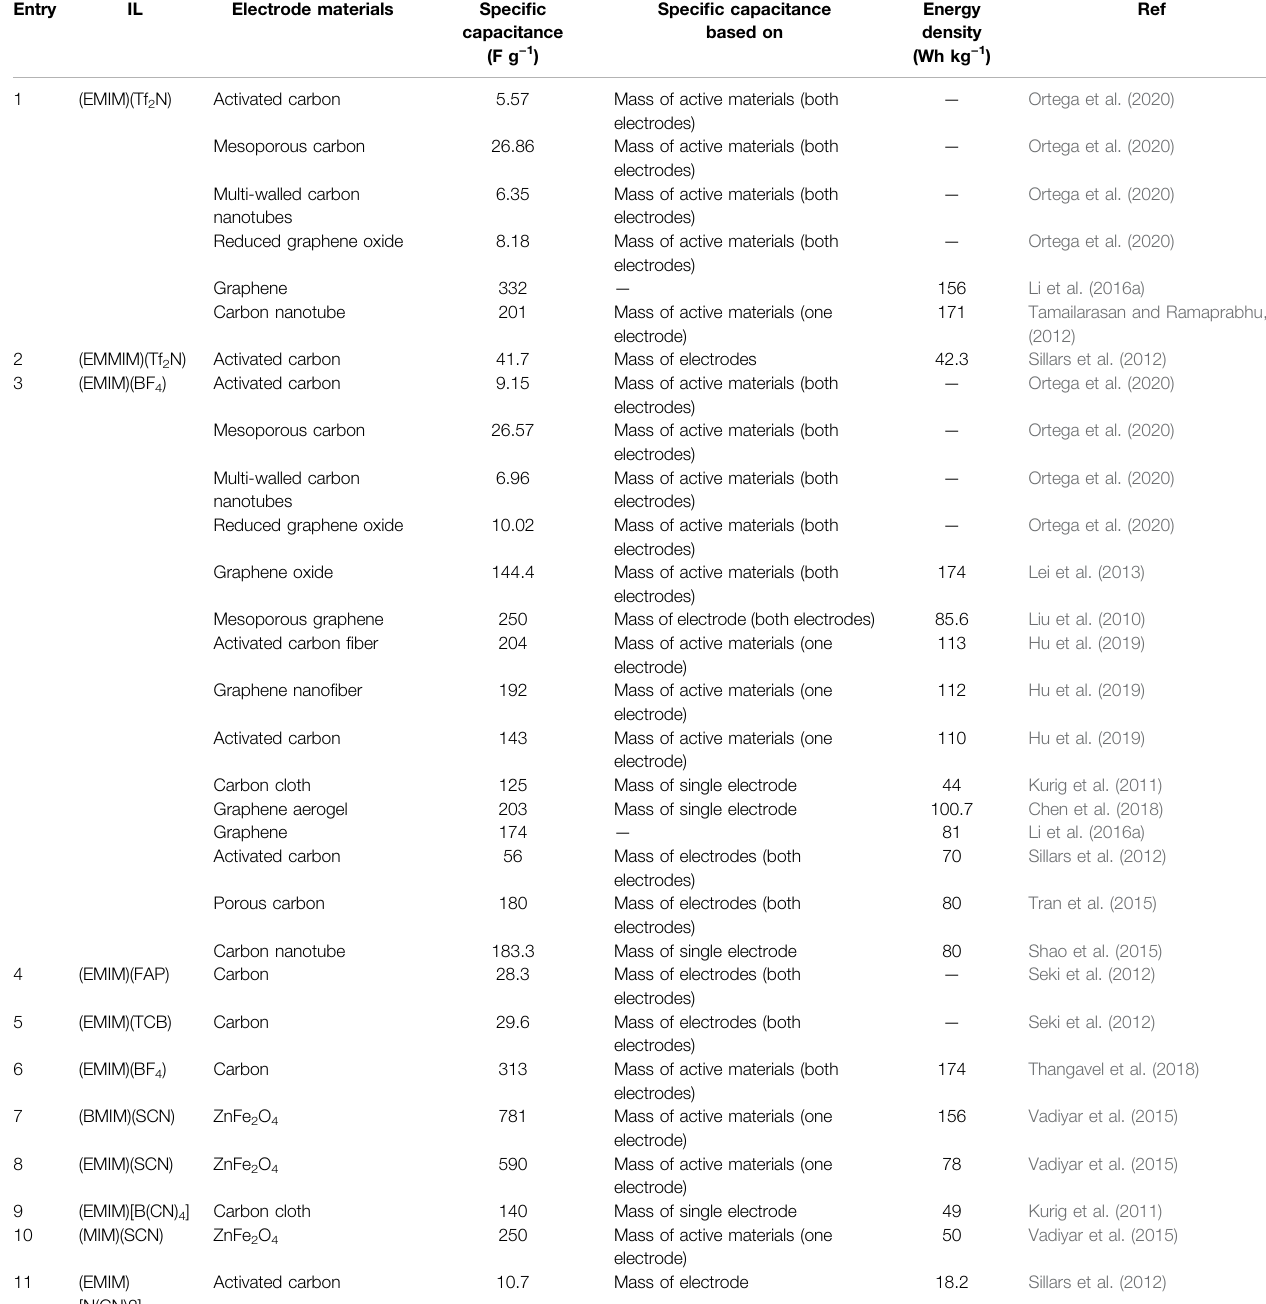
TABLE 2 | Summary of SC performance with imidazolium-based